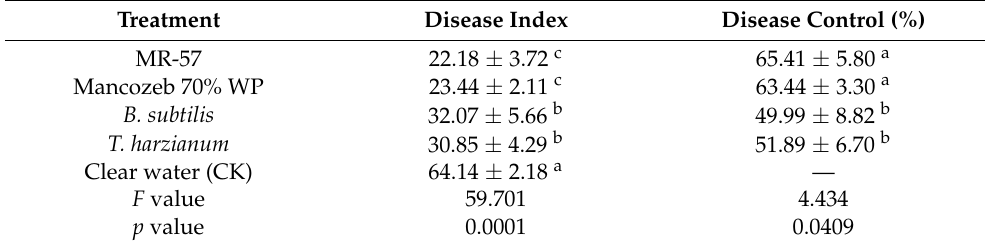
Table 2. Effect of the MR-57 spore suspension on root rot of S. divaricata